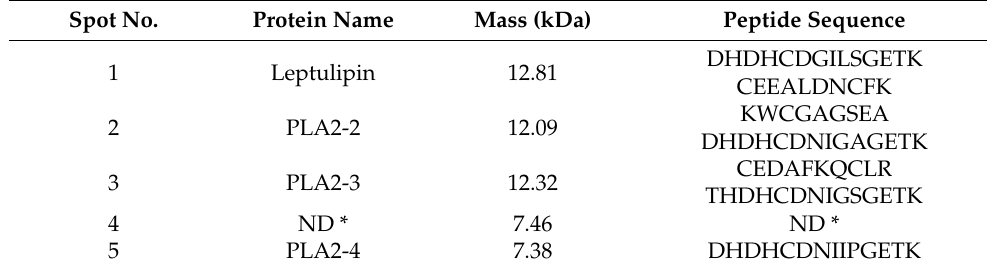
Table 2. The proteins identified from 2D electrophoresis spots. Spot